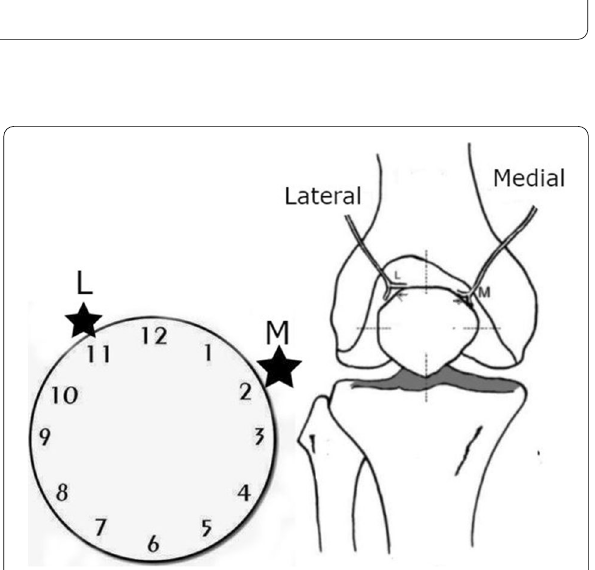
Fig. 7 Entry point of the patellar nerves on the right knee